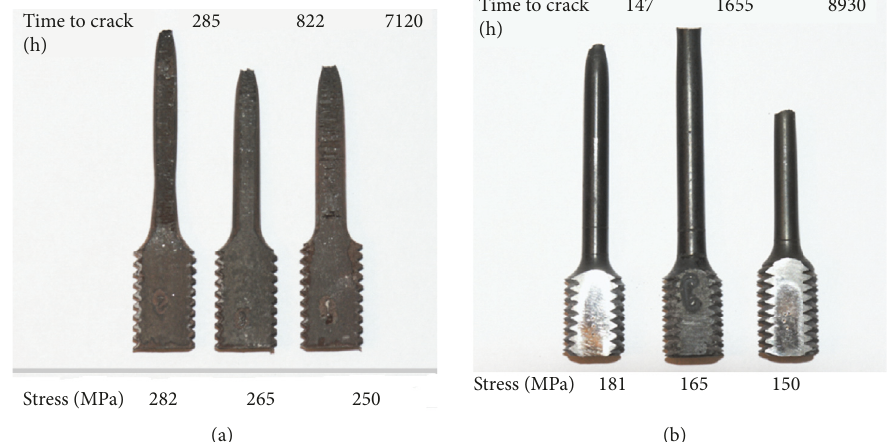
Figure 6: Fractures of steel. (a) Tensile specimens of C16E steel after creep exposition at 450 ∘ C; (b) fracture of H300LAD steel after creep exposition at 450 ∘ C.